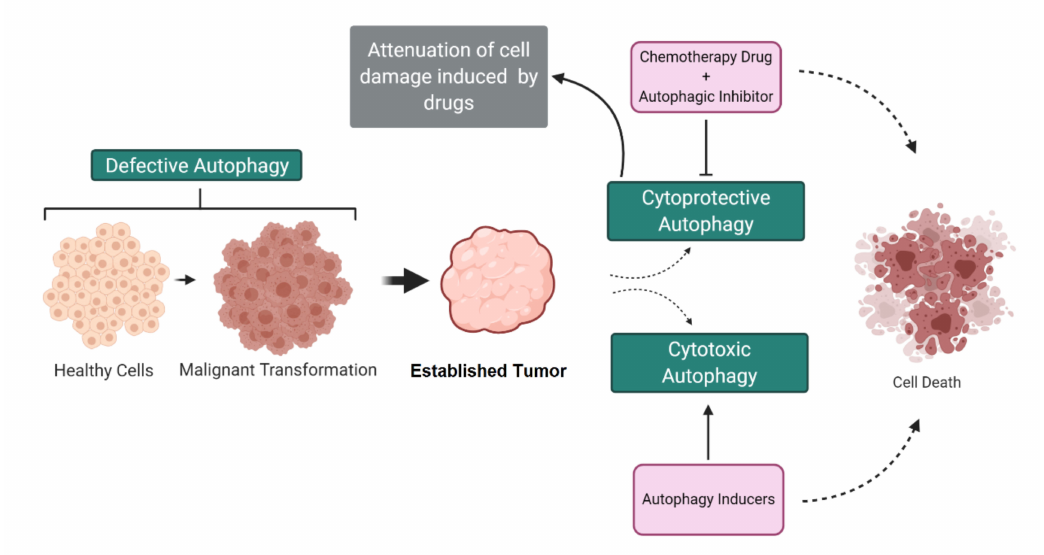
Figure 5. Di ff erent roles of autophagy in